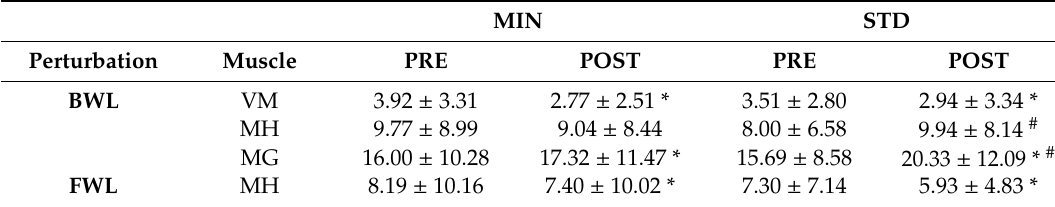
Descriptive statistics for mean muscle activity (mV) of all significant findings as mean ± standard deviation. MCT: motor control test. Perturbation types in MCT: BWL: Backward large; FWL: forward large. VM: vastus medialis; MH: medial hamstrings; MG: medial gastrocnemius; and TA: tibialis anterior. PRE: before the simulated military workload; POST: after the simulated military workload. MIN: Minimalist tactical military boot; STD: